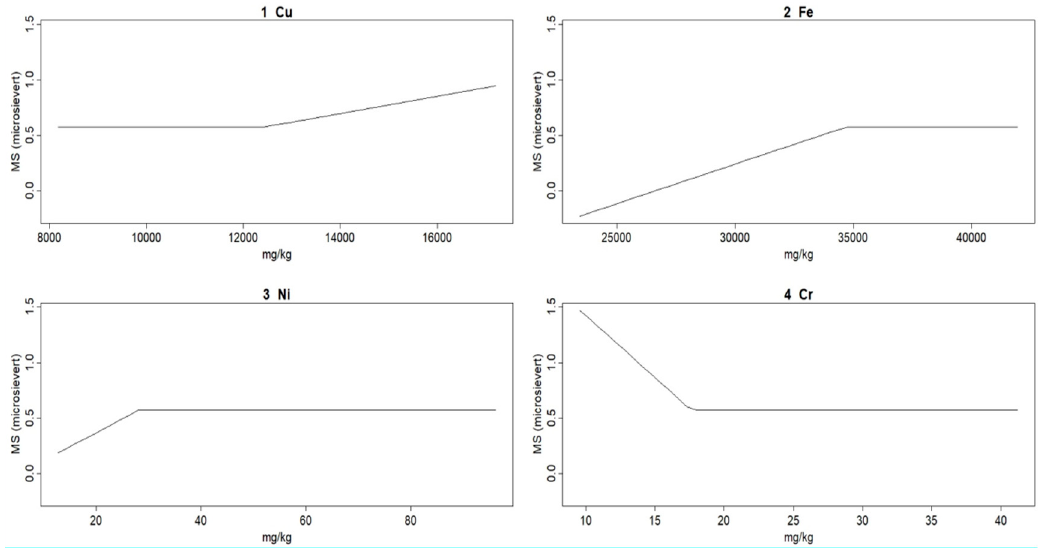
Figure 4. Relationship between metal concentration and magnetic susceptibility, discriminated by pmax functions.